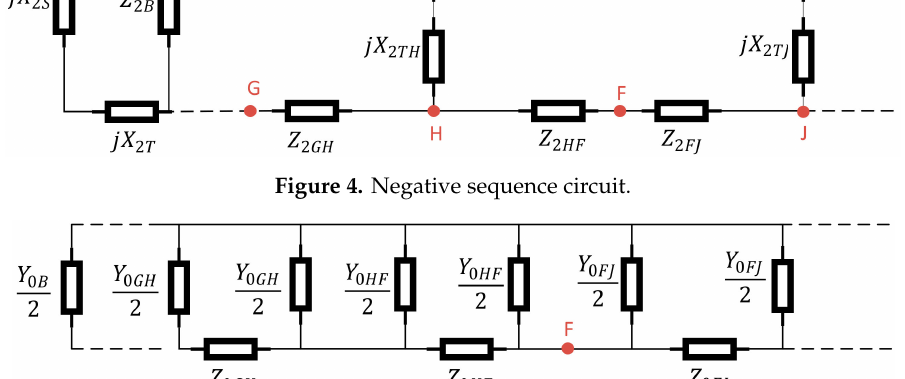
Figure 3. Positive sequence circuit.